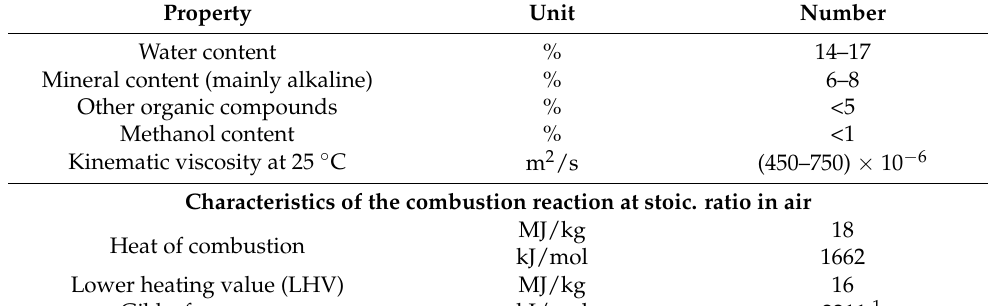
Table 1. Glycerol’s main physical properties